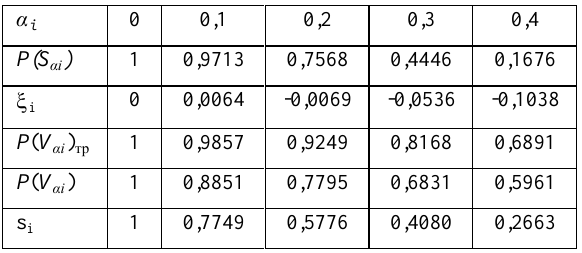
Table 3. Results of probabilistic parameters calculation along the third section (200-300 mm).